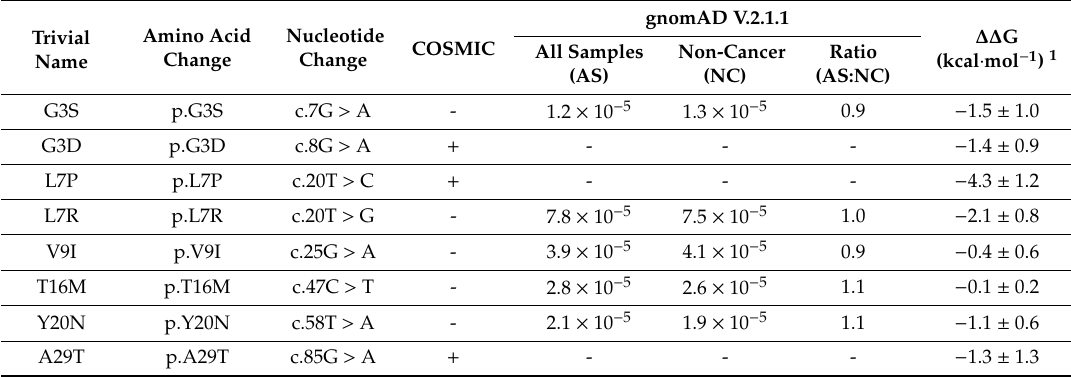
Table 1. NQO1 mutations experimentally characterized in this